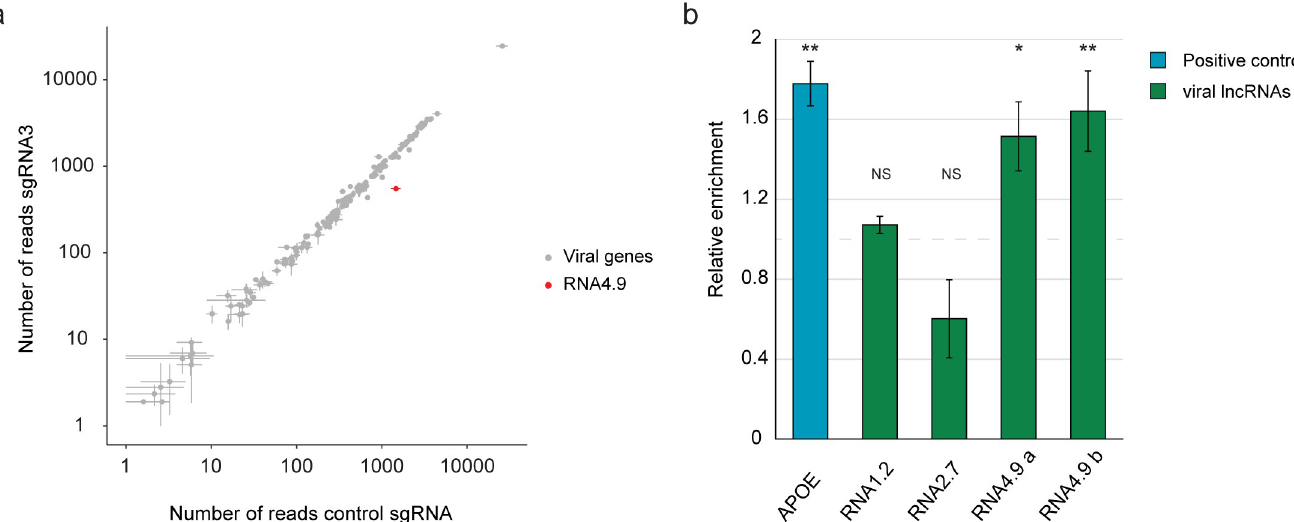
Fig 3. RNA4.9 forms R-loops and its Cas9 KD does not directly affect viral gene expression. a) Scatter plot presenting canonical viral gene expression in fibroblasts expressing CAS9 and a control sgRNA or a sgRNA targeting the RNA4.9 promoter (sgRNA3), which were infected with HCMV Merlin strain (MOI = 0.01), as measured by RNA-seq at 24 hpi with PFA treatment. The average and SD of two independent experiments is shown. b) Fibroblasts were infected with HCMV Merlin strain (MOI = 3) and cells were harvested at 48 hpi for DNA-RNA hybrid IP (DRIP). Enrichment of viral lncRNAs regions (green; RNA4.9 region was quantified using two sets of primers a and b) and an R-loop-forming cellular gene (APOE, blue; positive control) relative to the immunoprecipitation with an isotype control was quantified by qPCR. Fold-enrichment was calculated relative to a non-R-loop-forming cellular gene (SLC22A1). A relative enrichment of 1 represents no enrichment (dashed grey line). Values and error bars represent the average and SD of triplicates. A representative analysis of two independent experiments is shown. One-sided t - test was applied and compared to the non-R-loop-forming cellular gene (SLC22A1), ( �� p-value < 0.01, � p-value < 0.05, NS, not significant).